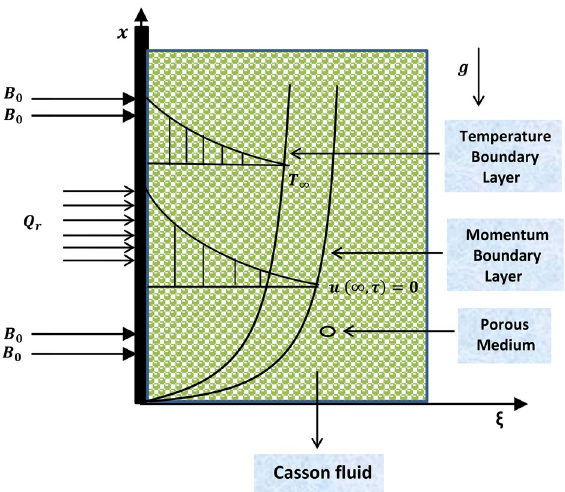
Figure 1. Geometry of the considered